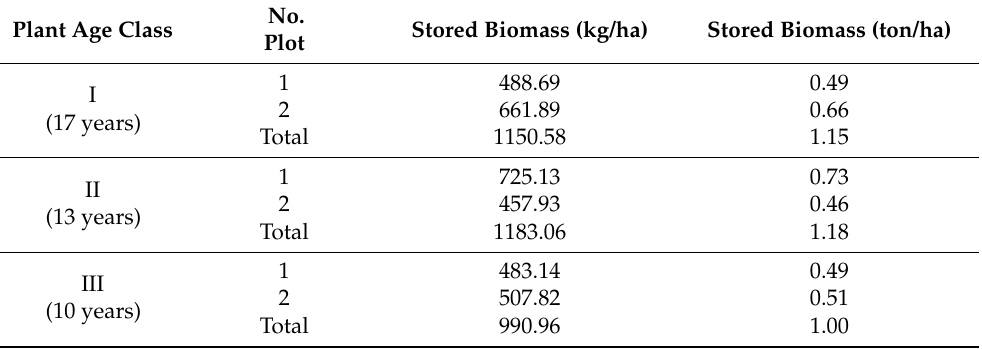
Table 2. The average amounts of stored biomass in the understory under D. polyphylla stands for 3 age